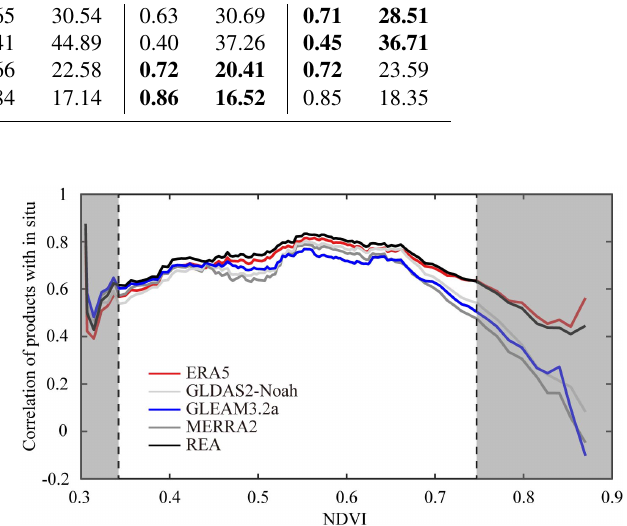
Figure 7. Evaluation over different vegetation densities (NDVI) of the merged product based on the correlation coefficient with station- observed